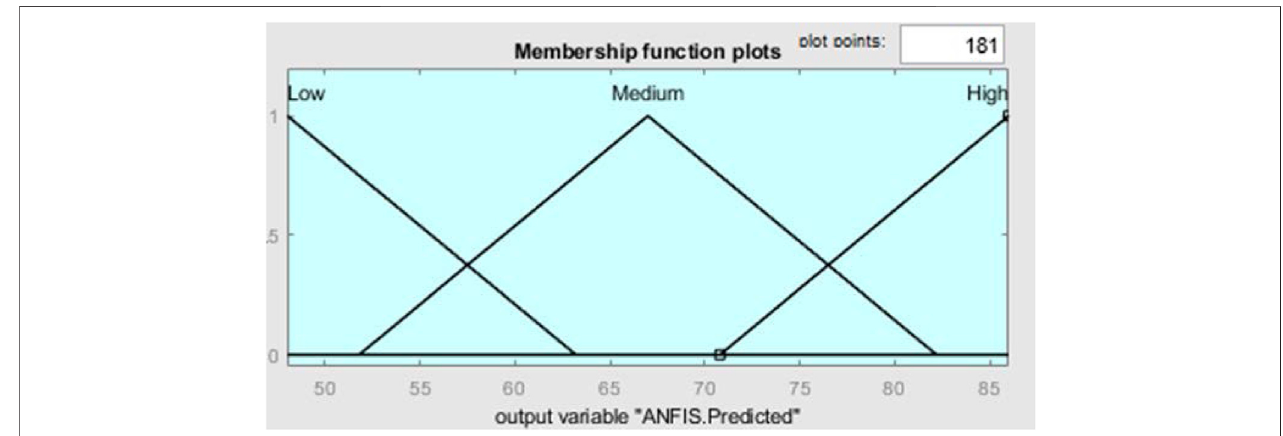
FIGURE 6 | Membership function plot of TSOME.